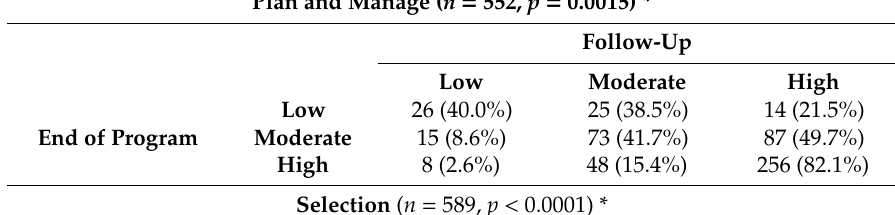
Table 4. Comparison between end-of-program and follow-up number of participants in low, moderate and high scoring groups for the three food literacy behaviour domains (a) plan and manage, (b) selection, and (c)